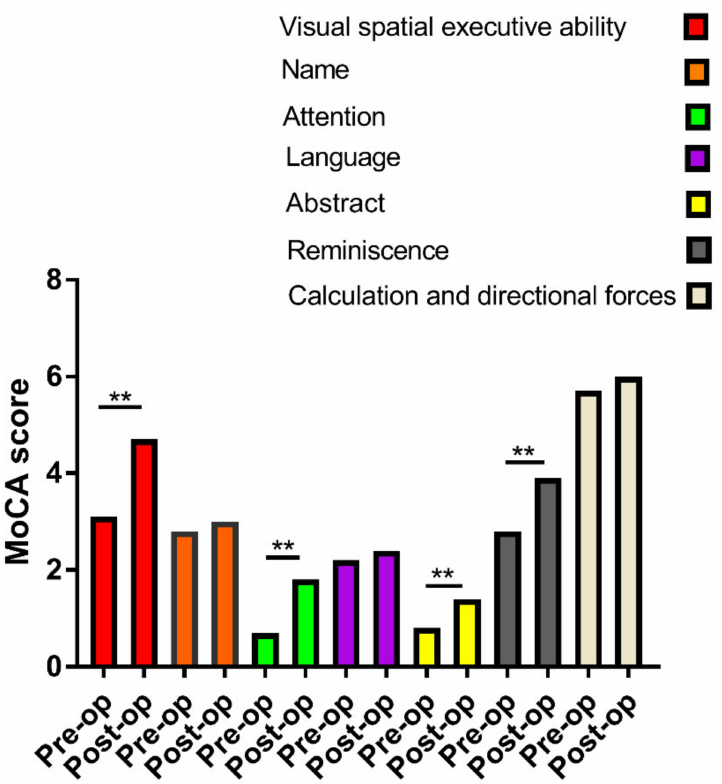
Figure 2. Comparison of details of MoCA score between preoperative and postoperative one year. ** p <